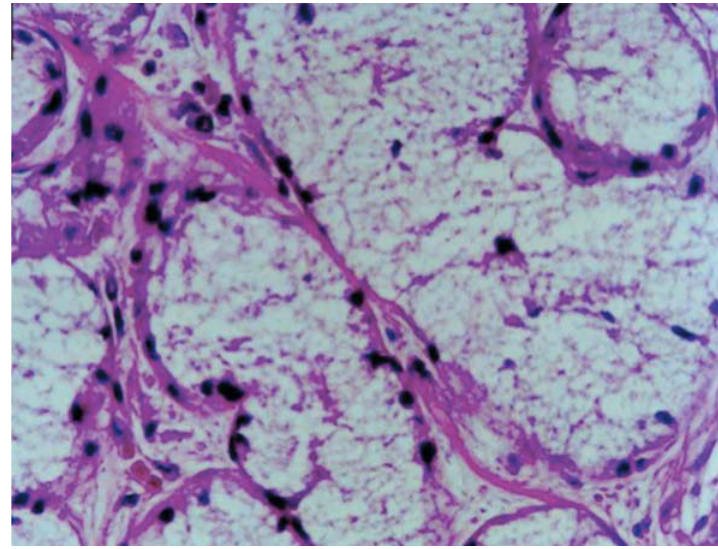
Figure 3- (cid:3)(cid:36)(cid:70)(cid:76)(cid:81)(cid:68)(cid:85)(cid:3)(cid:68)(cid:88)(cid:87)(cid:82)(cid:79)(cid:92)(cid:86)(cid:76)(cid:86)(cid:17)(cid:3)(cid:47)(cid:82)(cid:86)(cid:86)(cid:3)(cid:82)(cid:73)(cid:3)(cid:68)(cid:70)(cid:76)(cid:81)(cid:68)(cid:85)(cid:3)(cid:70)(cid:72)(cid:79)(cid:79)(cid:3)(cid:79)(cid:76)(cid:80)(cid:76)(cid:87)(cid:86)(cid:3)(cid:68)(cid:81)(cid:71)(cid:3)(cid:71)(cid:76)(cid:86)(cid:83)(cid:72)(cid:85)(cid:86)(cid:72)(cid:3)(cid:81)(cid:88)(cid:70)(cid:79)(cid:72)(cid:76)(cid:17)(cid:3)(cid:48)(cid:68)(cid:79)(cid:72)(cid:15)(cid:3)(cid:27)(cid:24)(cid:3)(cid:92)(cid:72)(cid:68)(cid:85)(cid:86)(cid:3)(cid:82)(cid:79)(cid:71)(cid:3)(cid:11)(cid:43)(cid:17)(cid:40)(cid:17)(cid:3)(cid:50)(cid:85)(cid:76)(cid:74)(cid:76)(cid:81)(cid:68)(cid:79)(cid:3)(cid:80)(cid:68)(cid:74)(cid:81)(cid:76)(cid:191)(cid:70)(cid:68)(cid:87)(cid:76)(cid:82)(cid:81)(cid:29)(cid:3) x400). H.E.=Hematoxylin & eosin